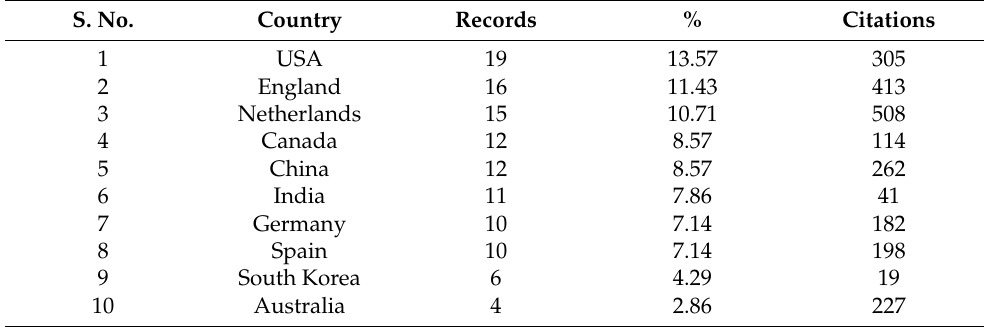
Table 5. The number and proportion of international collaboration articles published by the top ten most productive countries in health sciences research.